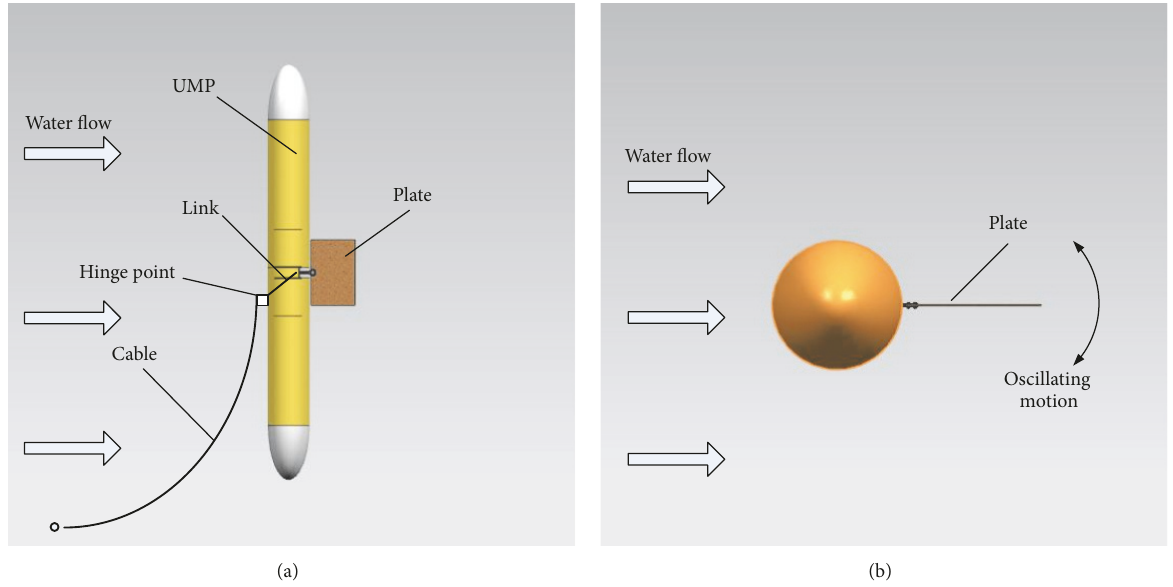
Figure 1: (a) Overall diagram of the UMP. (b) A schematic diagram of the splitter plate for rotation.